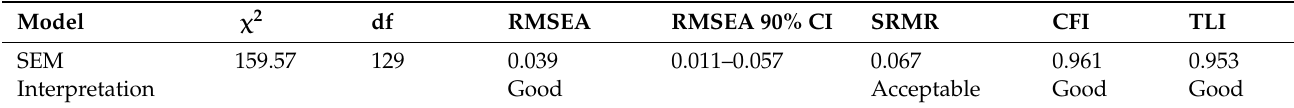
Table 6. Goodness of fit summary and interpretation.